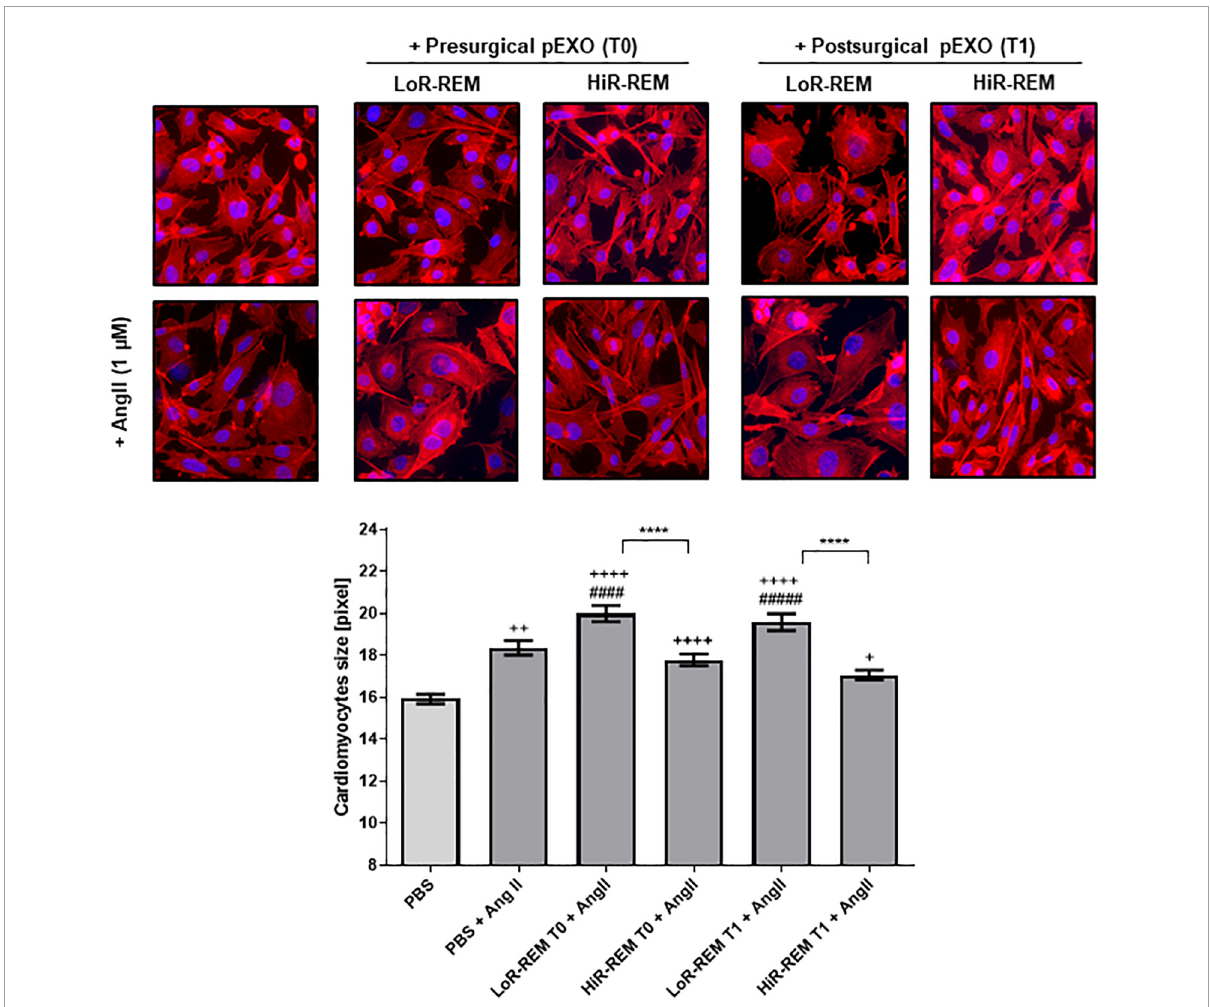
FIGURE6 Effect of pEXOs from patients with different grade of reverse ventricular remodeling on cardiomyocytes size. The HL-1 cells were seeded at a concentration of 5,000 cells/cm 2 and allowed to adhere for 24 h before treatment. To enlarge cardiomyocyte size, HL-1 cells were treated with ± 1- µ M Angiotensin II (AngII, Sigma) in complete Claycomb medium for 48 h. A PBS suspension of pEXOs isolated at T0 or T1 from HiR- or LoR-REM group ( N = 4 patients/group) was added to a final concentration of 1 × 10 9 particles/ml, 24 h after the beginning of the treatment, and the treatment was maintained for the remaining 24 h; PBS was employed as a control. The cell monolayer was stained with Phalloidin-Atto 550 as described in the methods. The images were acquired with a fluorescence microscope (Leica; 20 × magnification); the cell areas were manually measured with ImageJ software (https://imagej.nih.gov/ij/) and expressed in pixels. Statistical significance of the differences between treatments was evaluated by one-way ANOVA. The symbol “+” represents the significance of the differences against PBS alone (+, p < 0.05; ++, p < 0.01; ++++, p < 0.0001); “#” against PBS + AngII ( #### p < 0.0001); and “*” between LoR-REM and HiR-REM pEXO treatment in presence of AngII (**** p <